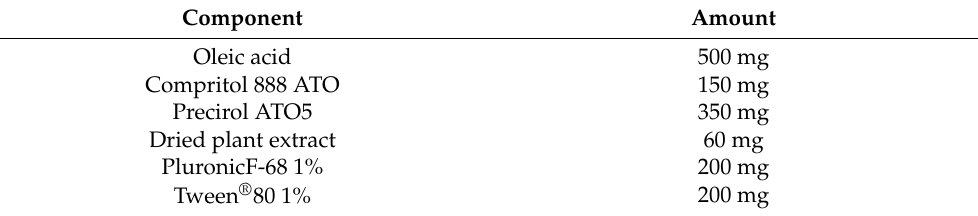
Table 1. The composition of C. speciosus Extract Loaded Nanostructured Lipid Carriers (CSE-NLCs). Component Amount Oleic acid 500 mg Compritol 888 ATO 150 mg Precirol ATO5 Dried plant